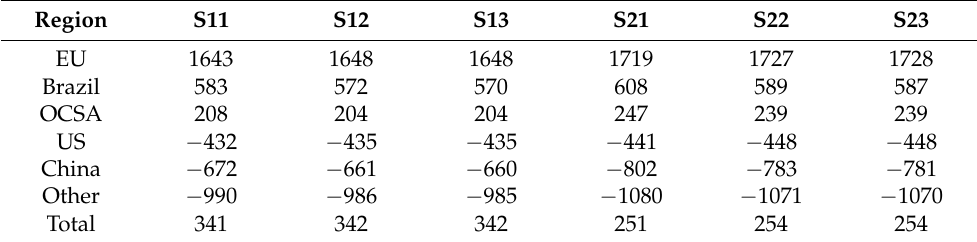
Table 2. Welfare impacts (EV) of the EU–Mercosur trade agreement (in million USD). Region S11 S12